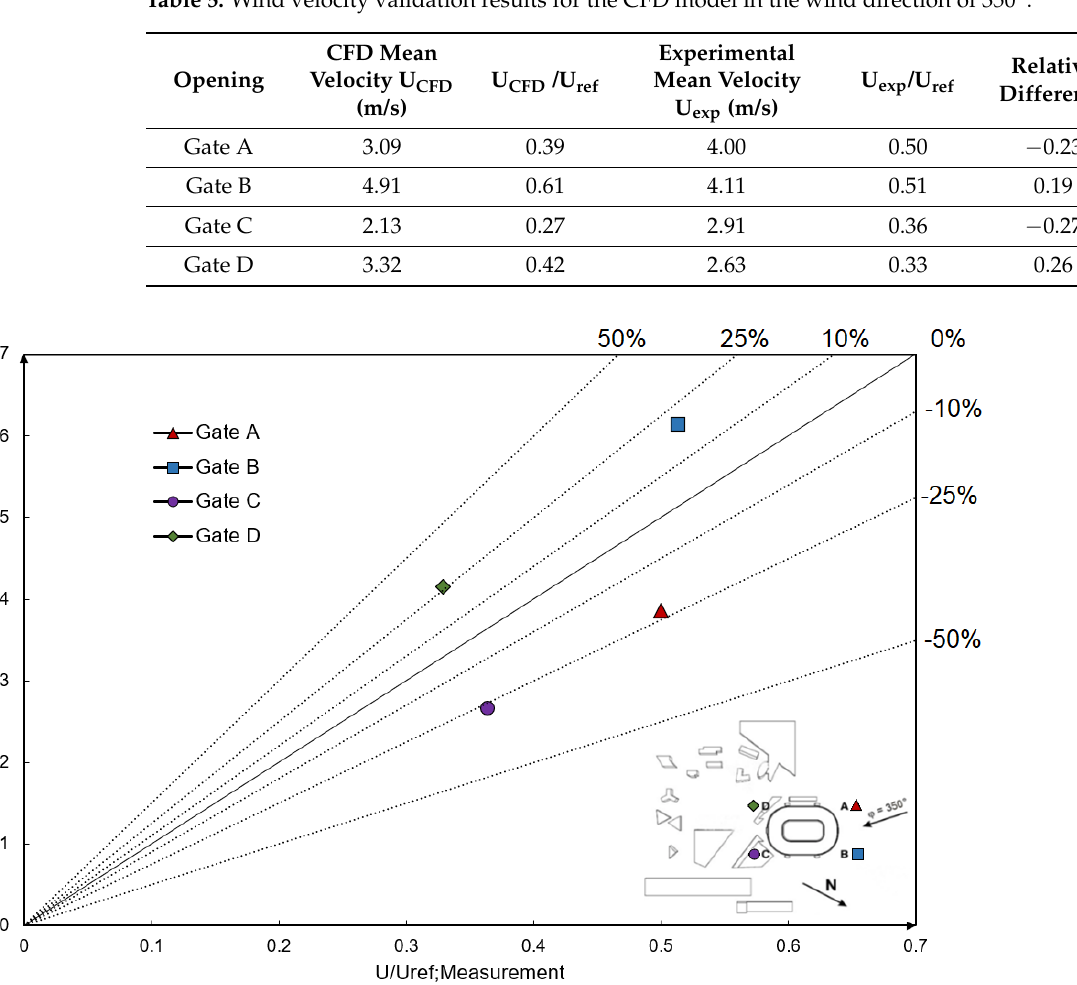
Figure 7. Wind velocity magnitude comparison between CFD simulations and on-site tests in the wind direction of 350°.